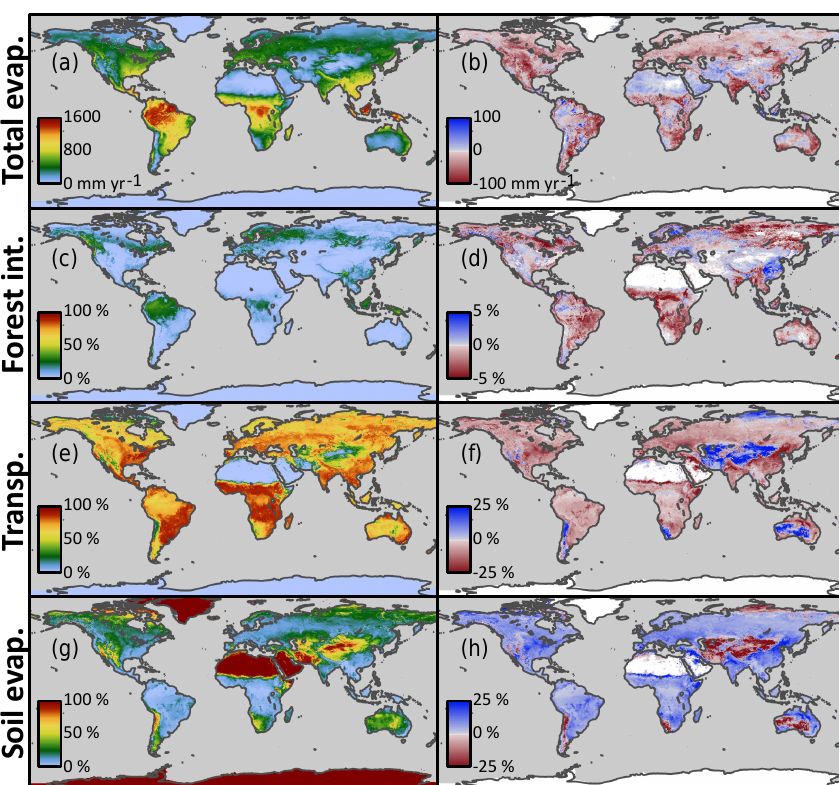
Figure 9. Global maps of terrestrial evaporation (top row) and the partitioning into its different components, i.e. forest interception loss (second row), transpiration (third row), and bare soil evaporation (bottom row) for the v3a data set. On top, the multi-annual total flux of evaporation for the v3a data set (left) and the difference with the v2a data set (right) are shown. The other maps show the percentage of the total flux in the v3a data set coming from the different components (left) and the difference with the same maps for the v2a data set